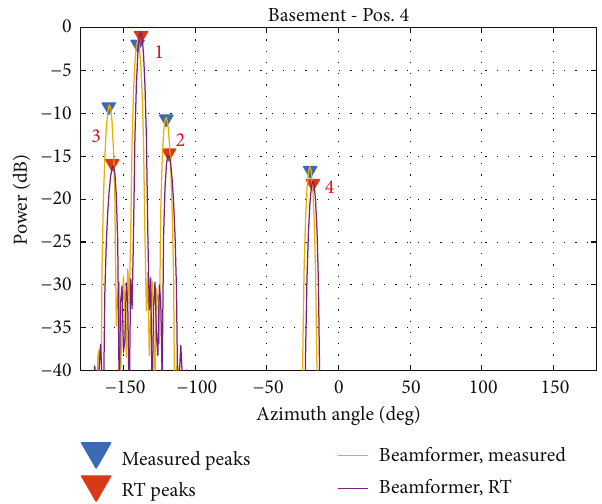
Figure 22: The identi fi ed 4 dominant paths in the measured and RT-simulated channels and the associated multiple beams for Tx position 4 in the basement scenario.